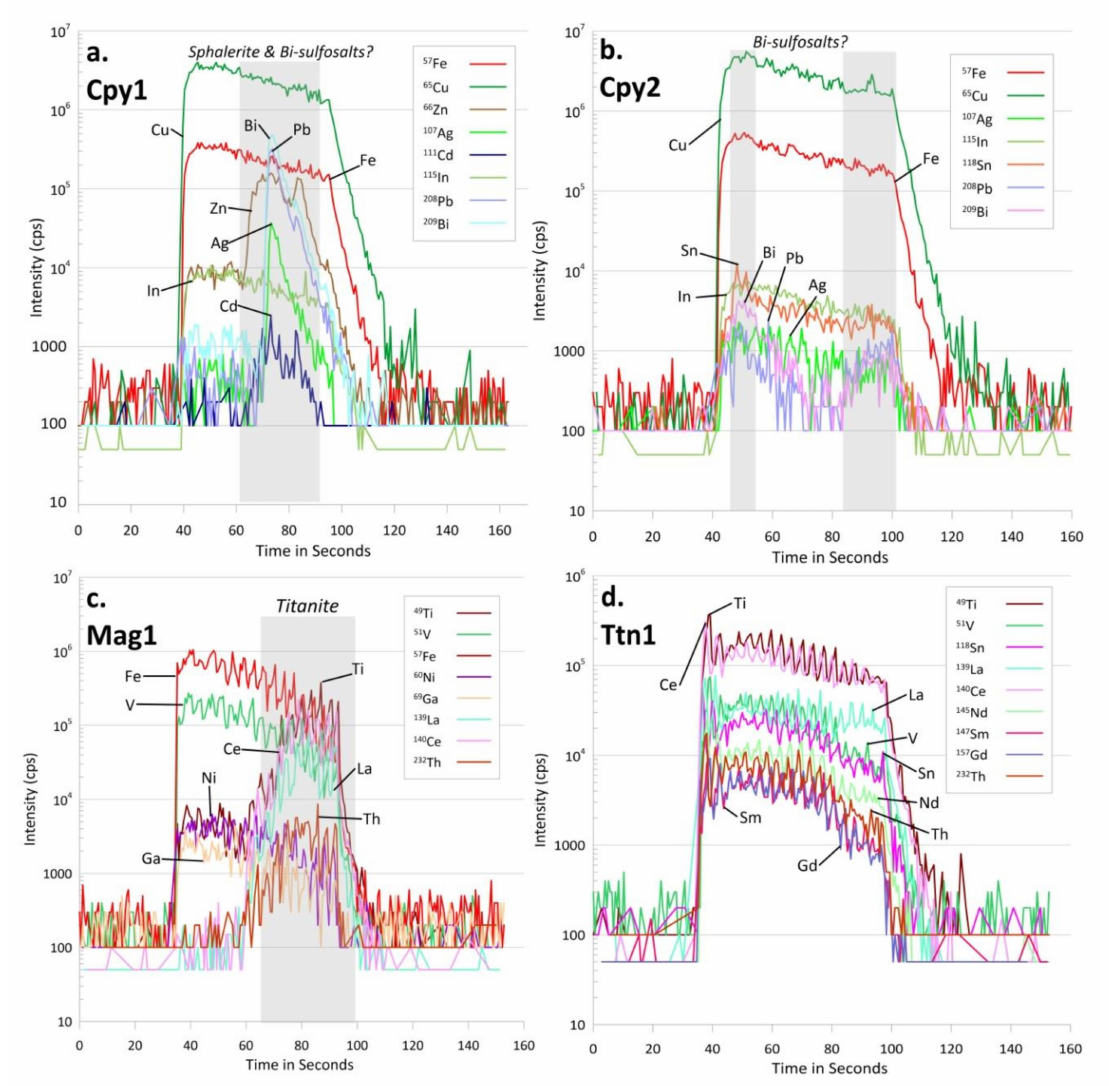
Figure 12. Selected time-resolved laser ablation ICP-MS depth profiles of chalcopyrite ( a , b ), magnetite ( c ), and titanite ( d ) and their associated inclusions (highlighted in gray). Iron, In, Ag, and Sn, where present, exhibit similar distribution patterns to Cu, in Cpy1 and Cpy2: ( a ) in Cpy1, the spiky patterns of Zn and Cd suggest the presence of sphalerite as nano-scale inclusions, while the more spiky patterns for Bi, Pb, and Ag could be related to nano-scale inclusions of silver-rich Bi-sulfosalts; ( b ) in Cpy2, the curved patterns of Bi and Pb could be associated with Bi-sulfosalts found as nano-scale inclusions; ( c ) in Mag1, vanadium, Ni, and Ga follow similar distribution patterns to iron, while the spiky patterns indicate a titanite inclusion in magnetite; in the titanite inclusion, La, Ce, and thorium follow the distribution patterns of Ti; ( d ) in Ttn1, vanadium, Sn, La, Ce, Nd, Sm, Gd, and Th show similar distribution patterns. Mineral inclusions were not detected in titanite